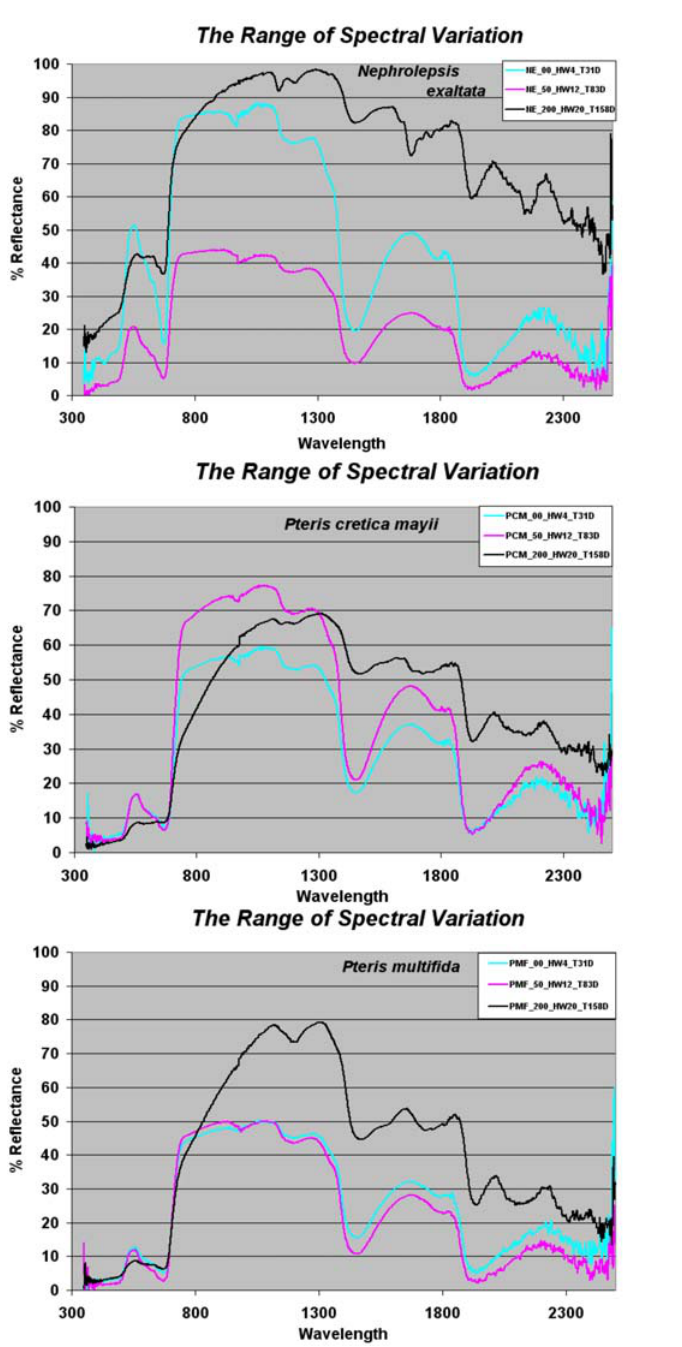
Figure 10. Spectral changes over time. A second data visualization technique plots the extremes of spectral variations of all three fern species; 0 ppm arsenic at 4 weeks, 50 ppm arsenic at 12 weeks and 200 ppm arsenic at 20 weeks. Distinct changes are